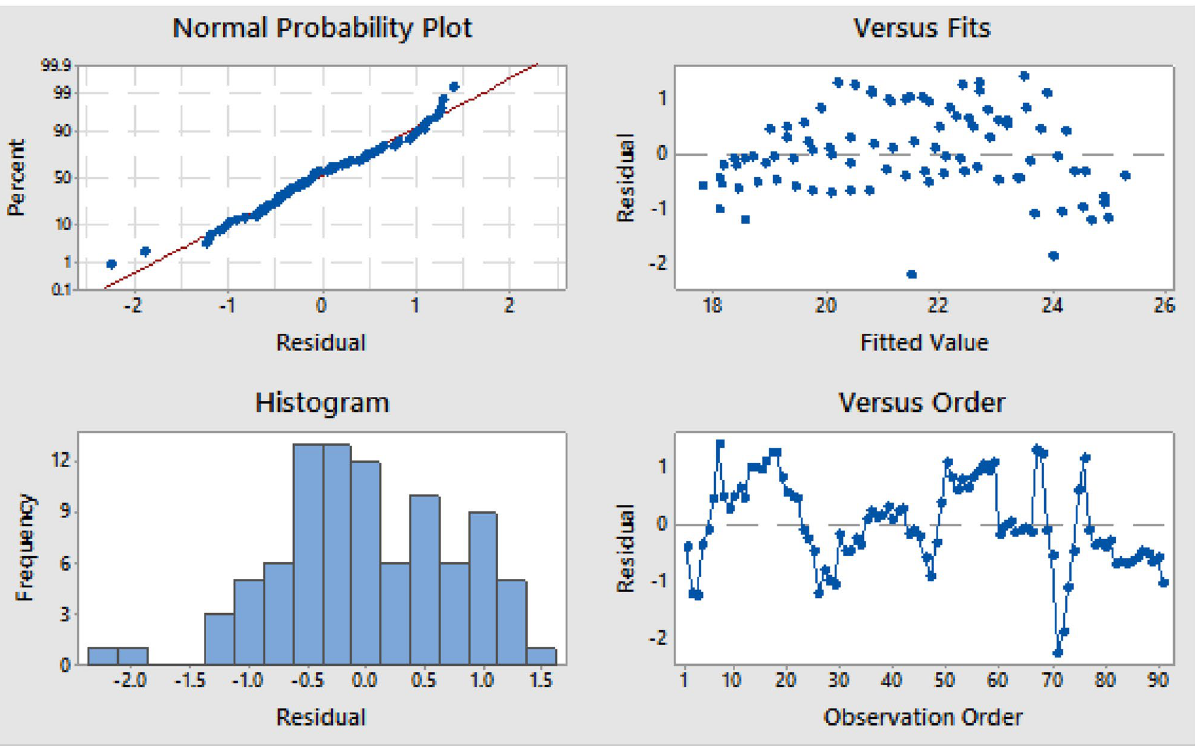
Figure 22. Residual plots for the target response using